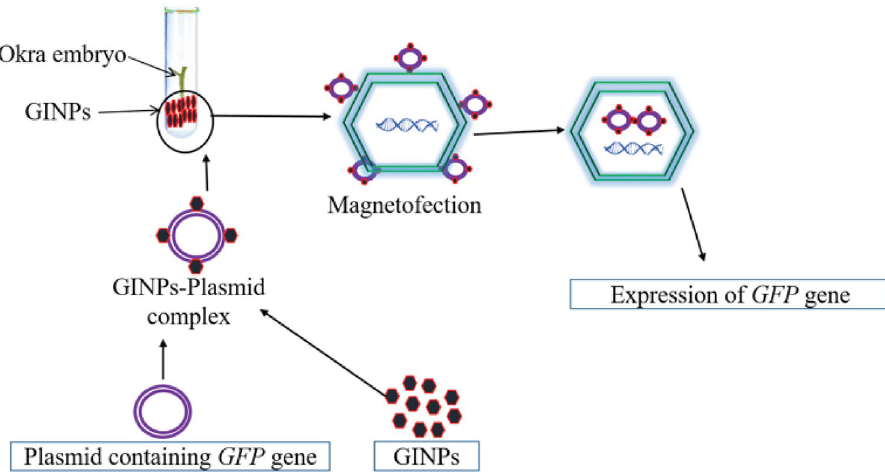
Figure 9. Schematic diagram showing the uptake of plasmid-nanoparticles complex by